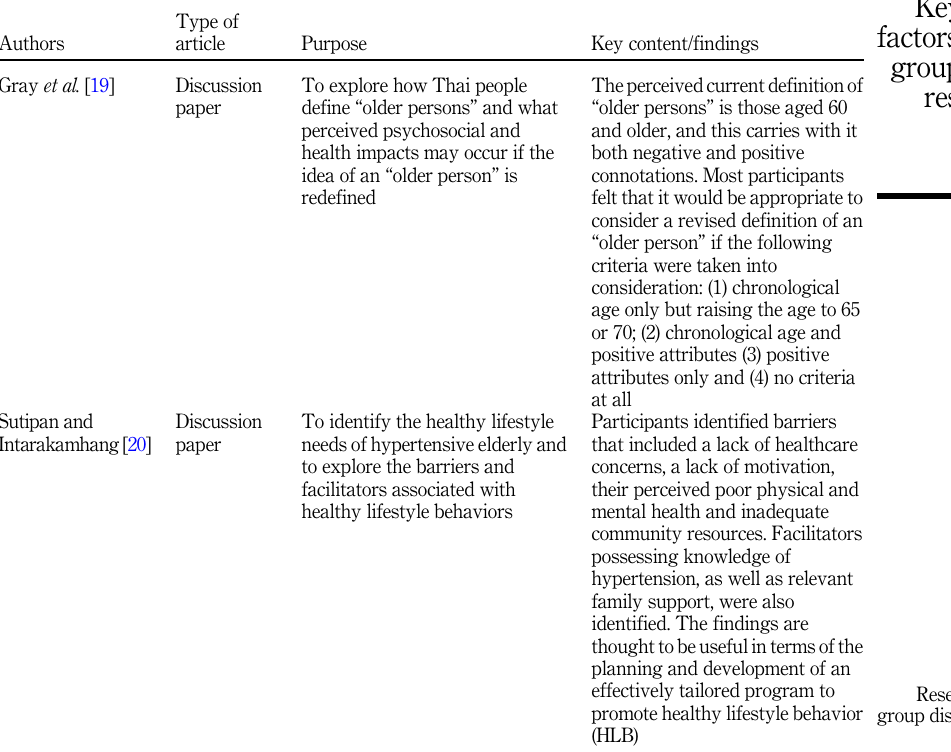
Table II. Research on